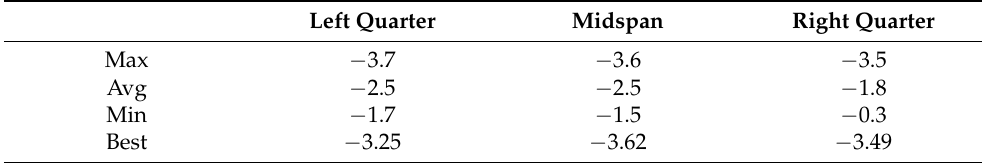
Table 5. Deformation tracking based on ICP point-to-plane.